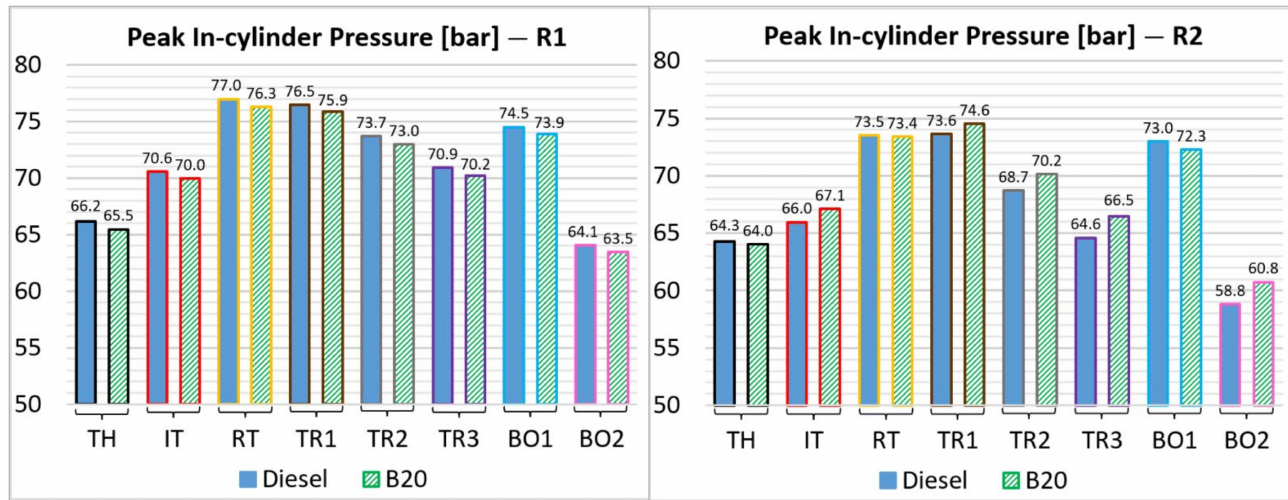
Figure 9. Peak in-cylinder pressure variation by different shapes of